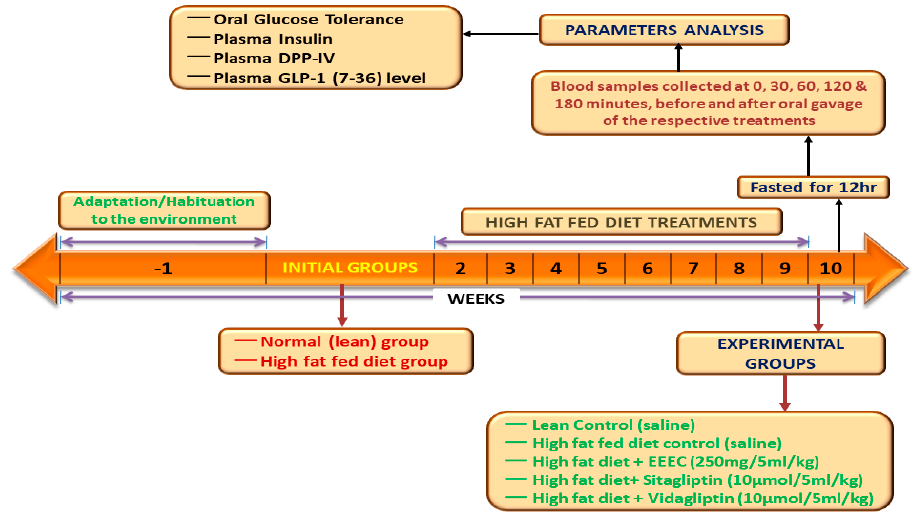
Figure 1. Schematic diagram represents the experimental design for animal